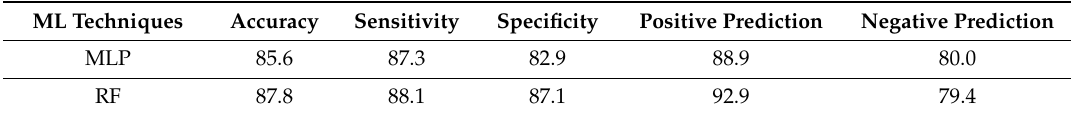
Table 4. Classification performance [%].